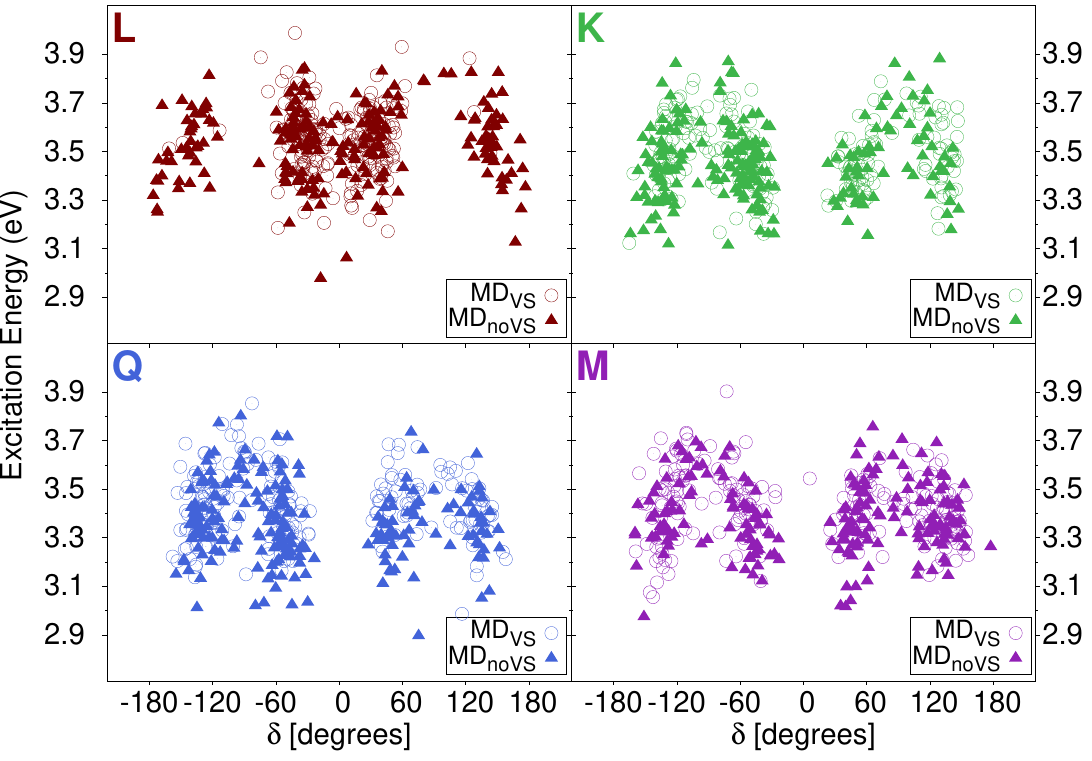
Figure 8. QM/FQ Excitation Energies of the first electronic transition of each studied flavonoid as a function of δ dihedral